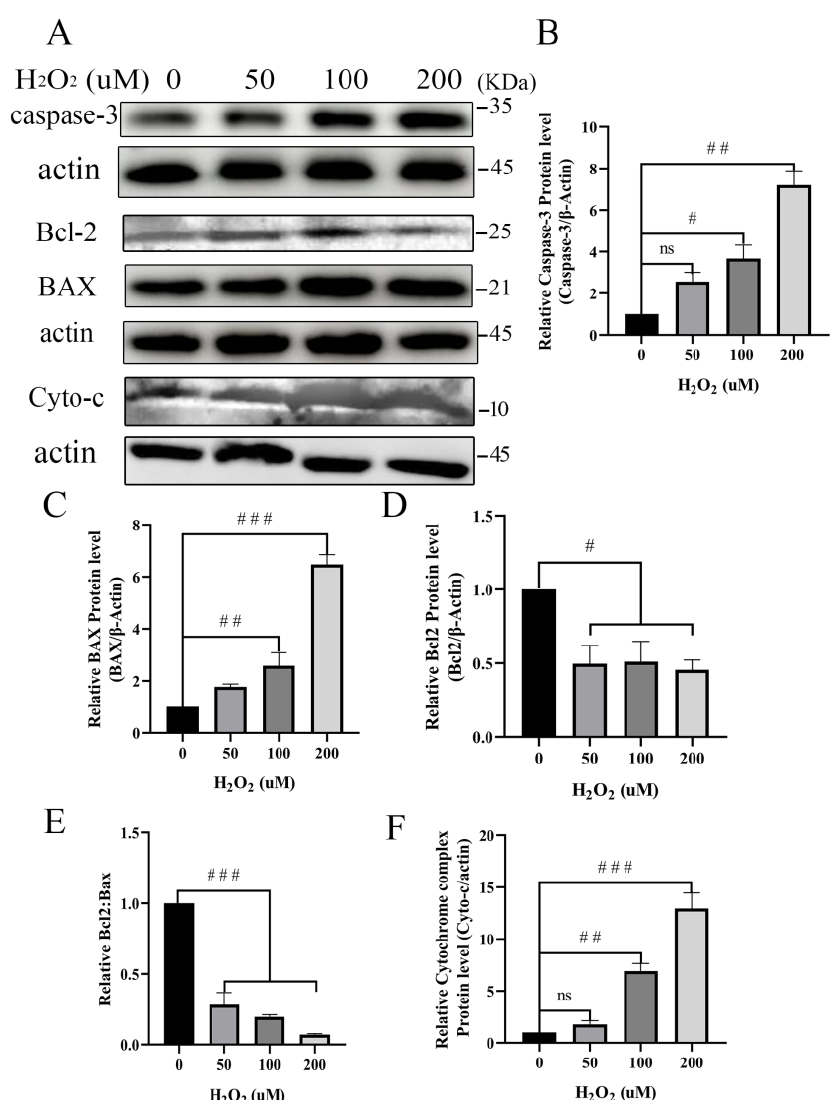
Figure 5. BEECs were treated with H 2 O 2 at different concentrations for five hours. Cells were prepared for Western blotting with antibodies against caspase-3, Bcl-2, BAX, and cyto-c. Expression relative to the β -actin reference was quantified using gray-scale analysis by ImageJ 1.47v software. The data are representative of three independent experiments. One-way ANOVA analysis was used to compared to the control group. # p < 0.05, ## p < 0.01, ### p < 0.001. ( A ) The protein expression of caspase-3, Bcl2, BAX, Cyto-c; ( B ) Expression level of caspase-3 relative to β -Actin; ( C ) Expression level of BAX relative to β -Actin; ( D ) Expression level of Bcl-2 relative to β -Actin; ( E ) Expression level of Bcl2:BAX; ( F ) Expression level of Cyto-c relative to β-Actin. Original Western Blot could be found as Supplementary Material.